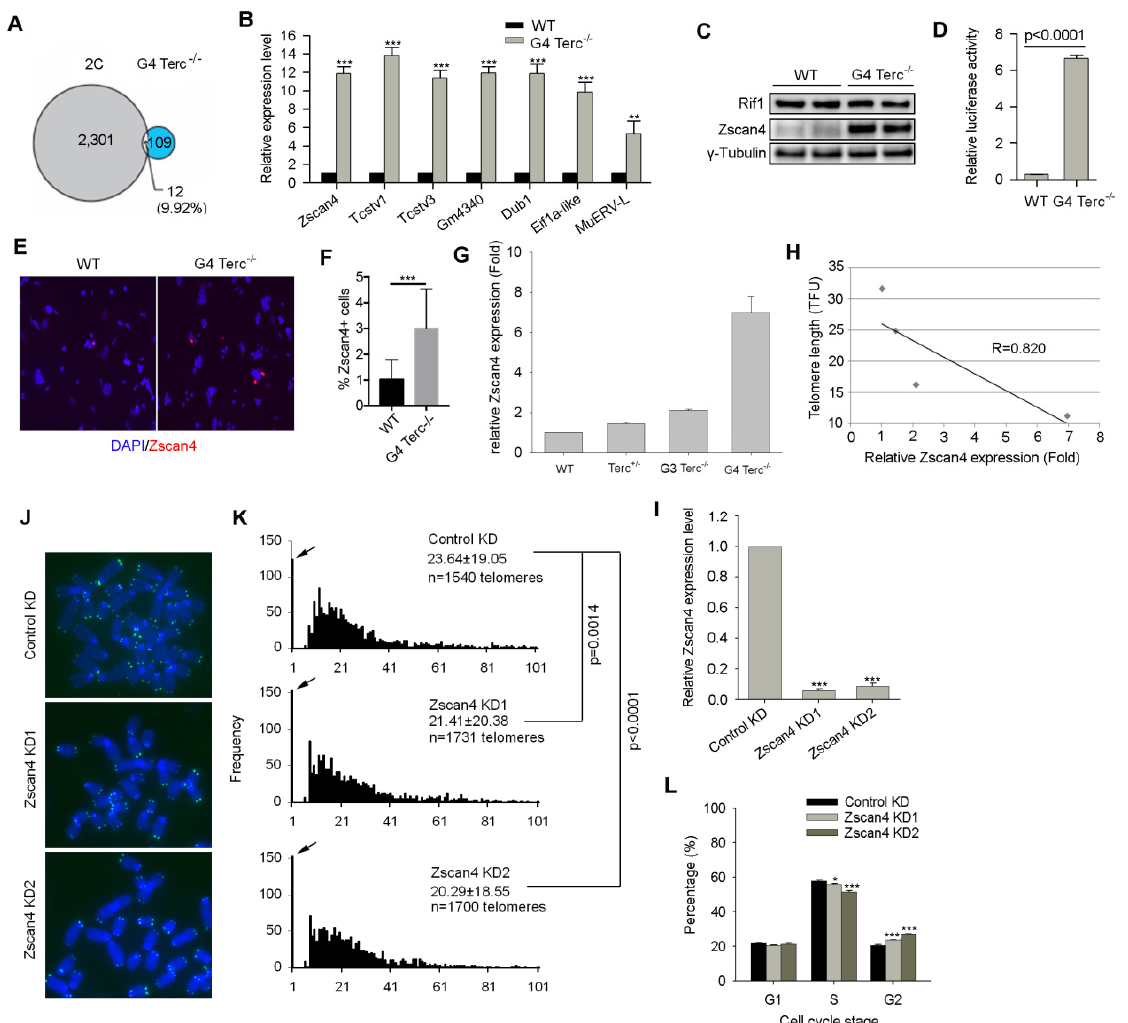
Figure 2. High expression level of Zscan4 contributes to telomere maintenance in G4 Terc ‐ / ‐ ES cells. ( A ) A Venn diagram shows the overlap between 2C ‐ genes and genes upregulated in G4 Terc ‐ / ‐ ES cells (2C ‐ gene data [32] and G4 Terc ‐ / ‐ data [7] were analyzed). ( B ) Two cell ‐ specific genes Zscan4 , Tcstv1 , Tcstv3 , Gm4340 , Dub1, Eif1a ‐ like, and MuERV ‐ L are all up ‐ regulated in G4 Terc ‐ / ‐ ES cells. Zscan4 , Tcstv1, and Tcstv3 are located at sub ‐ telomeric regions and Gm4340 is located at peri ‐ centro ‐ meric region in mouse genome. ( C ) Western blotting analysis of Zscan4 and Rif1 protein levels be ‐ tween WT and G4 Terc ‐ / ‐ ES cells. Two technical repeats were included. ( D ) Relative luciferase ac ‐ tivity of Zscan4c promoter between WT and G4 Terc ‐ / ‐ ES cells. ( E ) Representative Zscan4 immuno ‐ fluorescence images of Zscan4 + cells in WT and G4 Terc ‐ / ‐ ES cells. ( F ) Relative percentage of Zscan4 + cells. Error bars indicate mean ± SEM. ( G ) Comparison of Zscan4 relative expression levels by qPCR analysis of WT, Terc +/ ‐ , G3, and G4 Terc ‐ / ‐ ES cells. ( H ) Relative telomere length shown as TFU of ESCs is highly (R = 0.820) correlated with Zscan4 expression levels among different cells lines. The telomere length data used for correlation analysis were showed in our previous paper [7]. ( I ) Zscan4 mRNA levels were reduced by shRNA sequences targeting Zscan4 gene. ( J ) Representative telomere specific PNA ‐ FISH images of control and Zscan4 KD G4 Terc ‐ / ‐ ES cells. ( K ) Histogram shows telo ‐ mere distribution and relative lengths following Zscan4 KD by telomere QFISH. Frequency of telo ‐ mere end free ‐ signals is shown on Y ‐ axis indicated by arrows. Upper right ‐ hand corner, the average length ± SD. ( L ) Cell cycle progression analysis shows reduced S phase and increased G2 phase of G4 Terc ‐ / ‐ ES cells following knockdown of Zscan4 . Error bars indicate mean ± SEM ( n = 3). *, p < 0.05; **, p < 0.01; ***, p < 0.001, compared to controls.